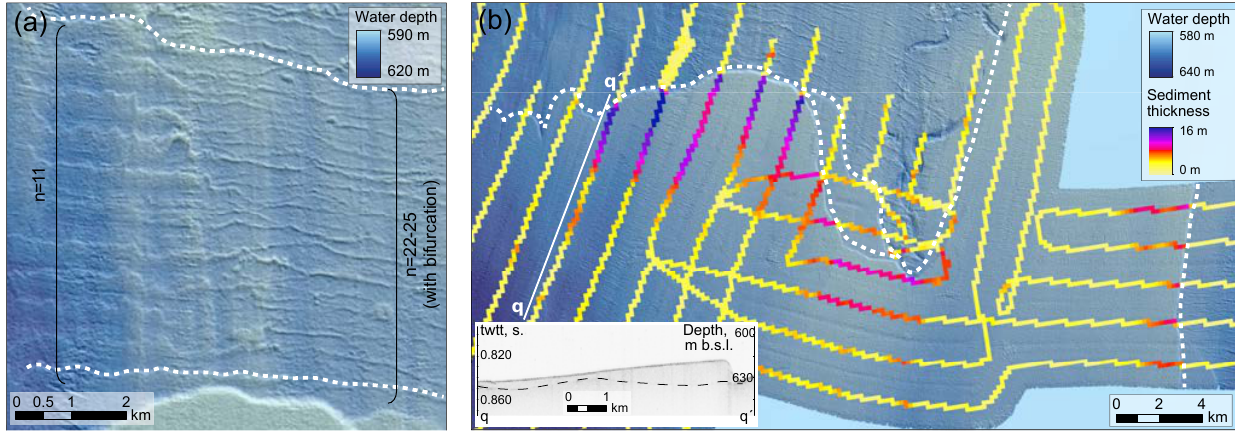
Figure 10. (a) Paired suite of laterally continuous grounding zone wedges and recessional moraines representing retreat of a single grounding line. Increased number of moraines relative to grounding zone wedges indicates that moraines mark shorter-lived grounding line positions. Individual grounding zone wedges have an average sediment content 8.3 times larger than their moraine counterparts. (b) Sediment thickness of an intermediately sized grounding zone wedge (partially visible at the bottom of (a) that was deposited above a buried horizon (inset)). Variations in sediment thickness are largest near the topset–foreset break with no distinct correspondence to the lobes and embayments of the grounding zone wedge.